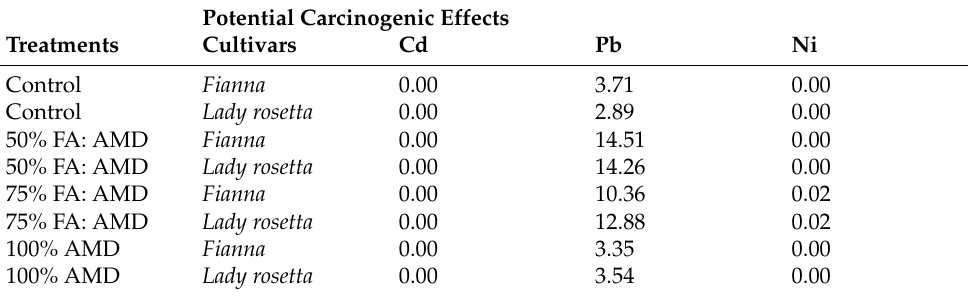
Table 5. Effect of AMD treatments on the Potential carcinogenic effects of two potato varieties ( Fianna and Lady rosetta